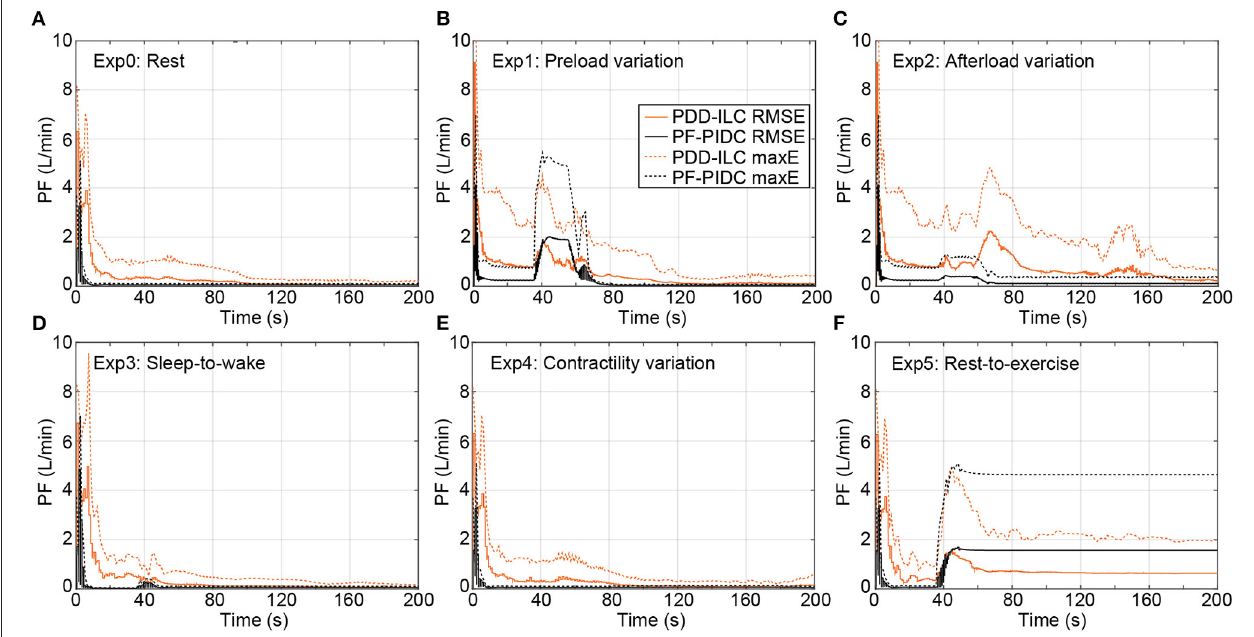
FIGURE 7 | Transient performance of the PDD-ILC and the PF-PIDC in terms of RMSE and maximum instantaneous error in tracking the reference trajectory under all physiological conditions and scenarios executed with the copulsation mode. (A) Rest-conditions (Exp0): The PDD-ILC converged after 100 iterations, obtaining an RMSE of 0.07 L min − 1 and maximum error of 0.19 L min − 1 . The PF-PIDC obtained an RMSE of 0.06 L min − 1 and maximum error of 0.11 L min − 1 . (B) Preload variation (Exp1): Last variation at 85 seconds. The converged RMSE and maximum error for the PDD-ILC was 0.07 L min − 1 and 0.23 L min − 1 , respectively. The RMSE and maximum error for the PF-PIDC was 0.05 L min − 1 and 0.08 L min − 1 , respectively. (C) Afterload variation (Exp2): Last variation at 85 seconds. The converged RMSE and maximum error for the PDD-ILC was 0.20 L min − 1 and 0.73 L min − 1 , respectively. The RMSE and maximum error for the PF-PIDC was 0.11 L min − 1 and 0.38 L min − 1 , respectively. (D) Sleep-to-wake (Exp3): Last variation at 85 seconds. The converged RMSE and maximum error for the PDD-ILC was 0.05 L min − 1 and 0.21 L min − 1 , respectively. The RMSE and maximum error for the PF-PIDC was 0.06 L min − 1 and 0.11 L min − 1 , respectively. (E) Contractility variation (Exp4): Last variation at 85 seconds. The converged RMSE and maximum error for the PDD-ILC was 0.05 L min − 1 and 0.18 L min − 1 , respectively. The RMSE and maximum error for the PF-PIDC was 0.06 L min − 1 and 0.10 L min − 1 , respectively. (F) Rest-to-exercise (Exp5): Last variation at 85 seconds. The converged RMSE and maximum error for the PDD-ILC was 0.68 L min − 1 and 2.46 L min − 1 , respectively. The RMSE and maximum error for the PF-PIDC was 1.56 L min − 1 and 4.63 L min − 1 , respectively. RMSE, root mean square error; maxE, maximum error; PDD-ILC, physiologic data-driven iterative learning controller; PF-PIDC, pump flow proportional-integral-derivative